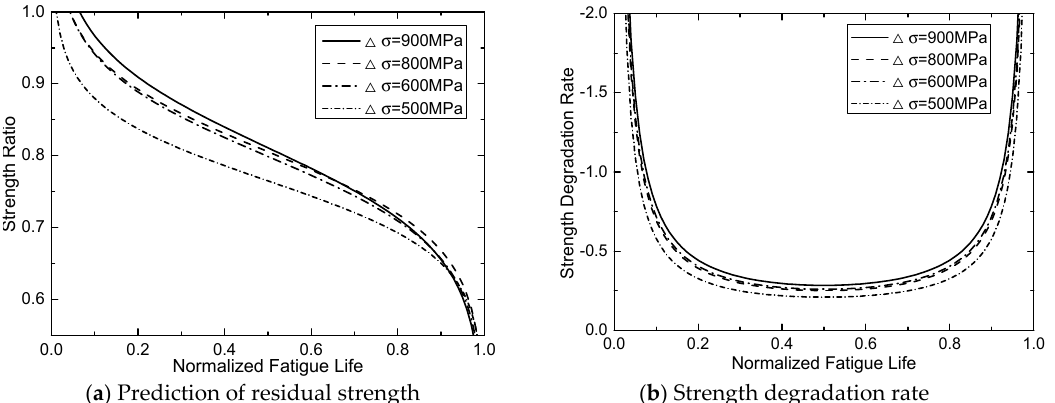
Figure 7. Residual strength predictions of new proposed model: ( a ) prediction of residual strength, ( b ) strength degradation rate.